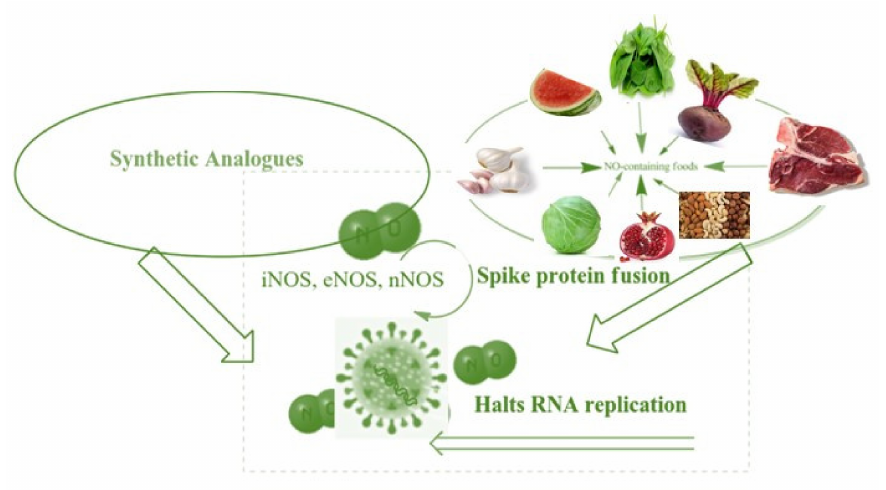
Figure 2. Anti-coronavirus activity of NO as inorganic ligand. Reproduced from ref. [93]. Ahmed et al. (2022) combined 2,2-(ethylenedioxy)bis(ethylamine) with